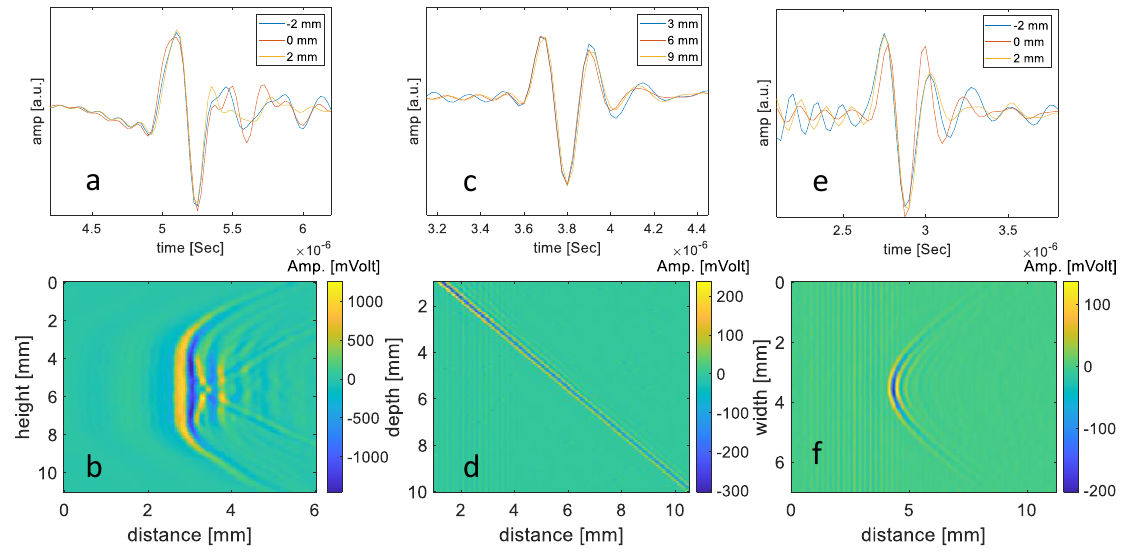
Figure 3. The acoustic signals, measured for an optoacoustic point source scanned in the elevational ( a , b ), axial ( c , d ), and lateral ( e , f ) directions. In the top panel, 3 waveforms are shown for specific displacement values: −2 , 0, and 2 mm. In the bottom panel, the acoustic data from the scan are presented as 2D images, which are a function of the position of the point source and time.